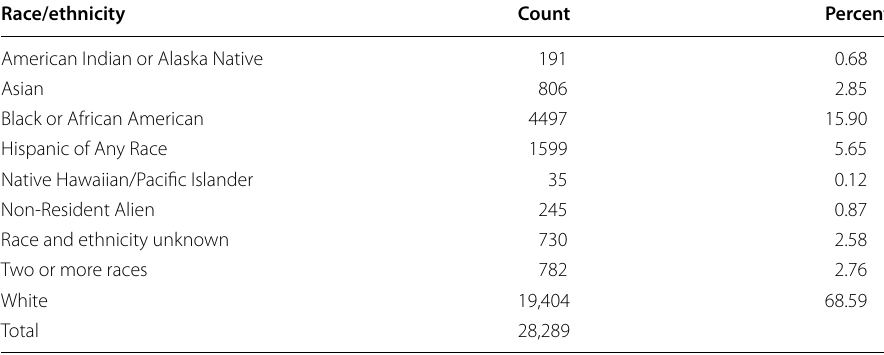
Traditionally, we have a larger fraction of White students in our introductory physics class than the university in general. This is a common pattern in physics across